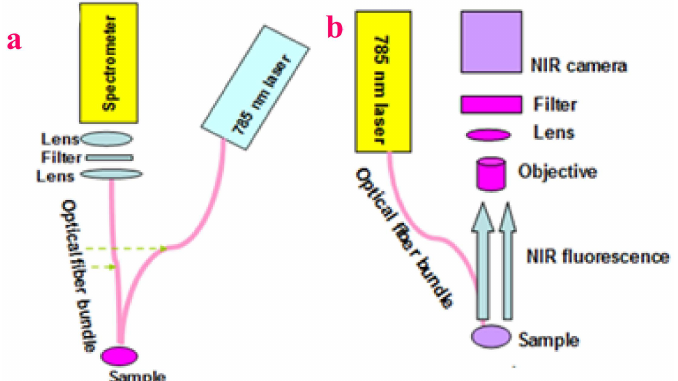
Figure 13. ( a ) Set-up for near-infrared fluorescence spectra measurement. ( b ) Near-infrared fluorescence imaging setup.